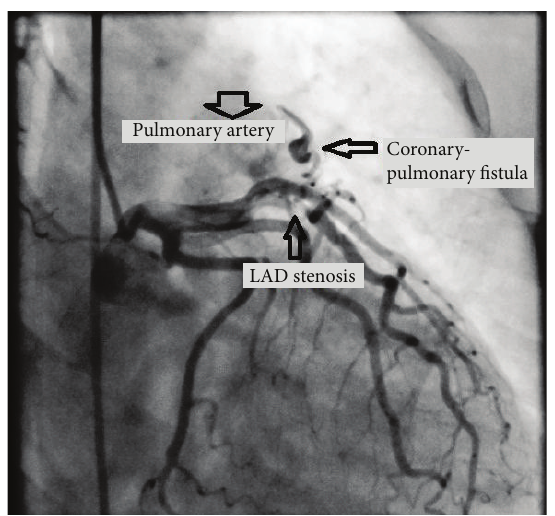
Figure 1: Angiographic view of coronary fistula between left inter- nal thoracic artery and pulmonary artery.